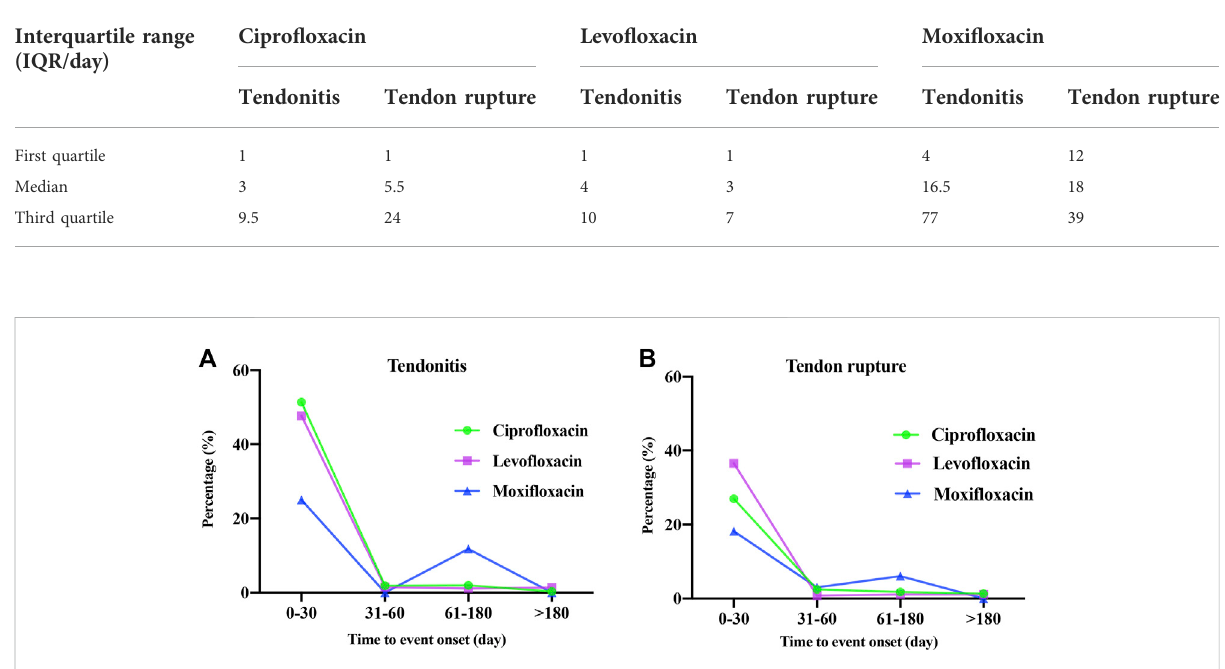
FIGURE 2 Onset time of cipro fl oxacin-, levo fl oxacin- and moxi fl oxacin-associated tendonitis (A) and tendon rupture (B)